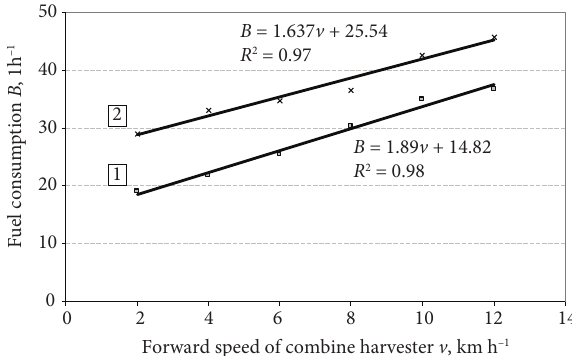
Figure 2. Effect of driving speed of combine harvester B over stubble on hourly fuel consumption when n = 1965 rpm. (1) indicates that technological gears are switched off, and (2) indicates that they are switched on